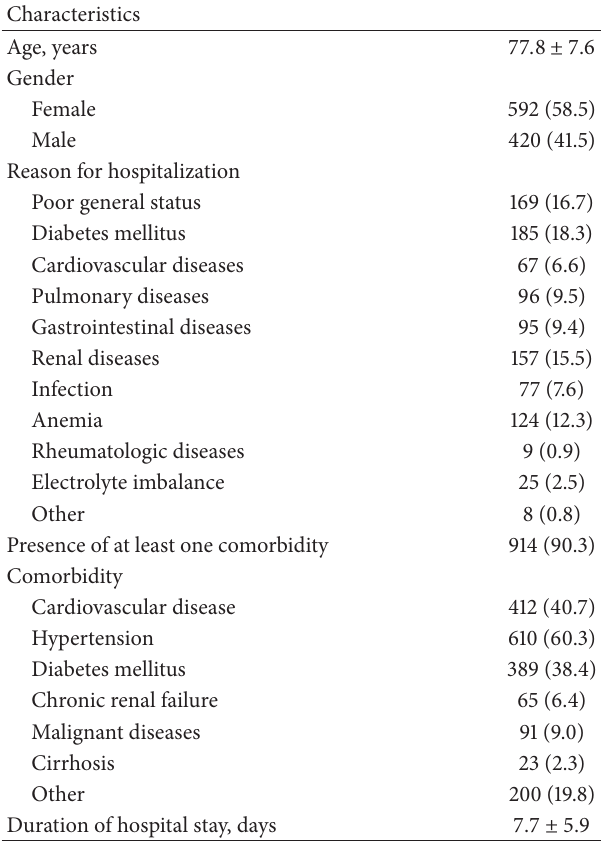
Table 1: General characteristics of the